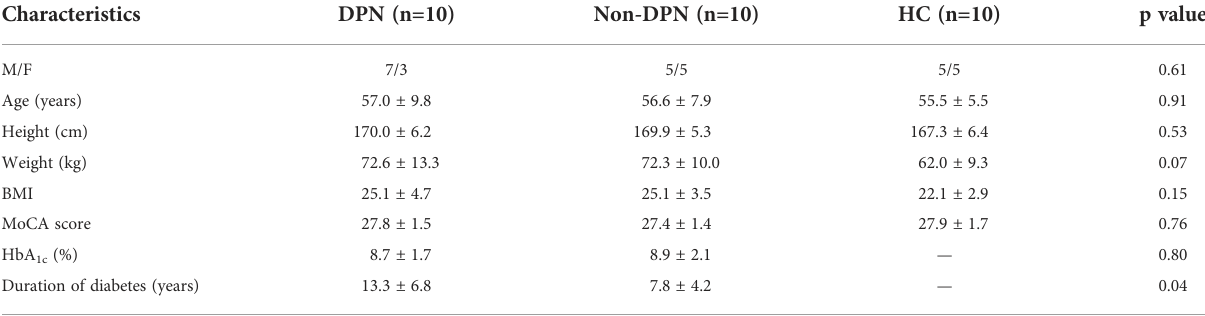
TABLE 1 Baseline information and characteristics of the all